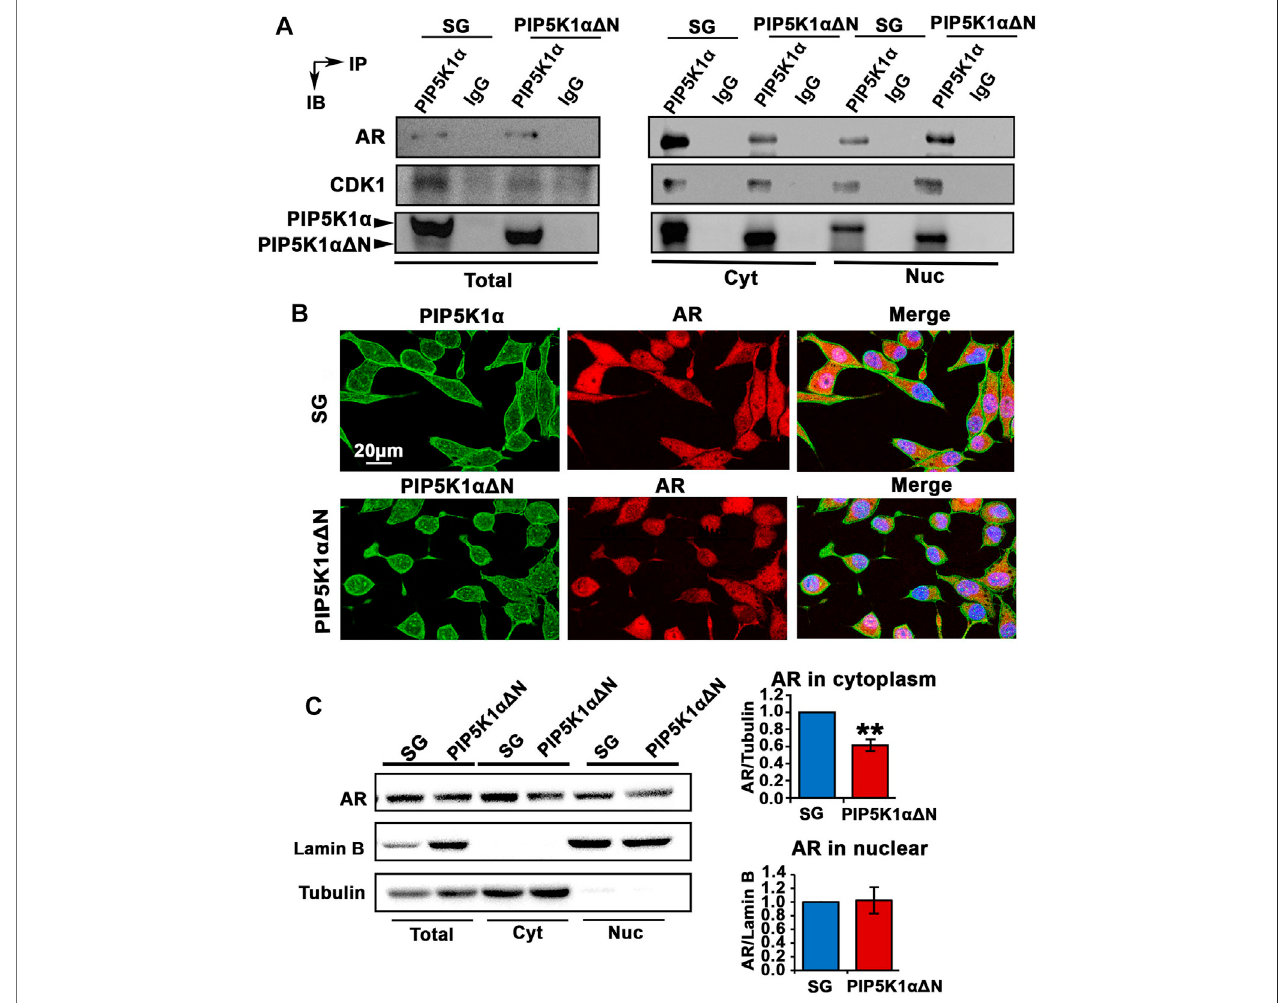
FIGURE 7 | Biological consequences of N-terminal truncated PIP5K1 α cells on AR transcriptional activity and AR-associated signalling related to castration resistance. (A) Immunoprecipitation assay was performed to examine the formation of protein-protein complexes between PIP5K1 α / Δ PIP5K1 α and AR in total cell lysates(Total),cytoplasmic(Cyt)and nuclear(Nuc) subcellularfractions ofSGcellsand PIP5K1 αΔ Ncells. Theprotein lysates weresubjected totheimmunoprecipitation (IP) assay.Antibody against PIP5K1 α wasused topulldown and antibody toIgGwasusedasanegative control. Antibodies against AR,CDK1 and PIP5K1 α were used for immunoblot analysis (IB). The formation of complexes between PIP5K1 α / proteins and AR or CDK1 in different cellular compartments are shown. (B) Representative immuno fl uorescent images show the subcellular localization of AR in red and PIP5K1 α proteins in green in SG cells and PIP5K1 αΔ N cells. Scale bar: 20 μ m. (C) Immunoblot analysis ofAR expression in total cell lysates, cytoplasmic and nuclear compartments ofSG and PIP5K1 αΔ N cells are shown. Tubulin wasused asthemarkerforcytoplasmicfraction,whileLaminBwasusedasamarkerforthenuclearfraction.Quanti fi cationsoftheimmunoblotsofARinsubcellularcompartments are shown. Data in this fi gure is presented as the average of three independent experiments (±SE). Student ’ s t -test was used in the analysis. ** p < 0.01 is indicated.